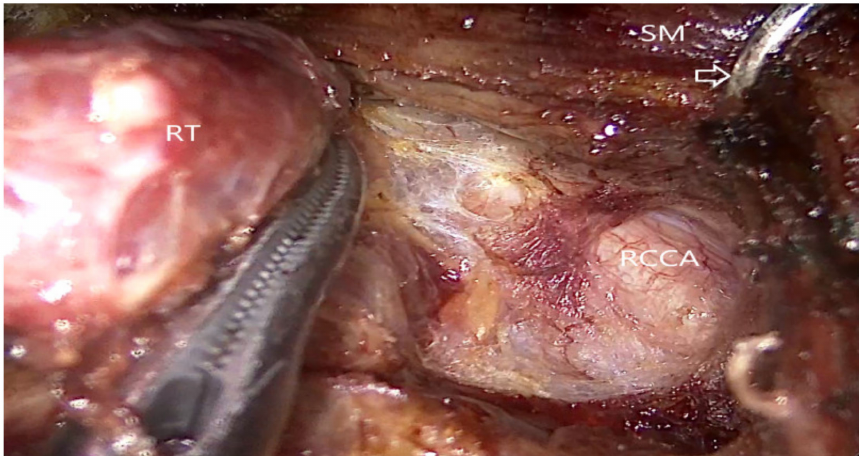
Figure 2. Endoscopic view of the transoral endoscopic thyroidectomy vestibular approach. RT: right thyroid gland, RCCA: right common carotid artery, SM: strap muscle, Arrow: external